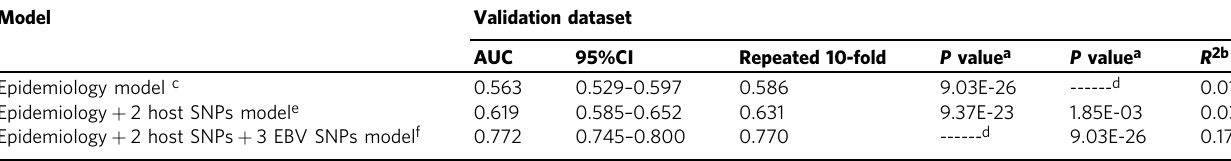
AUC area under the curve, CI con fi dence interval, repeated 10-fold, average AUC from repeated 10-fold cross-validation. a The P value was calculated using a two-sided Delong ’ s test. b